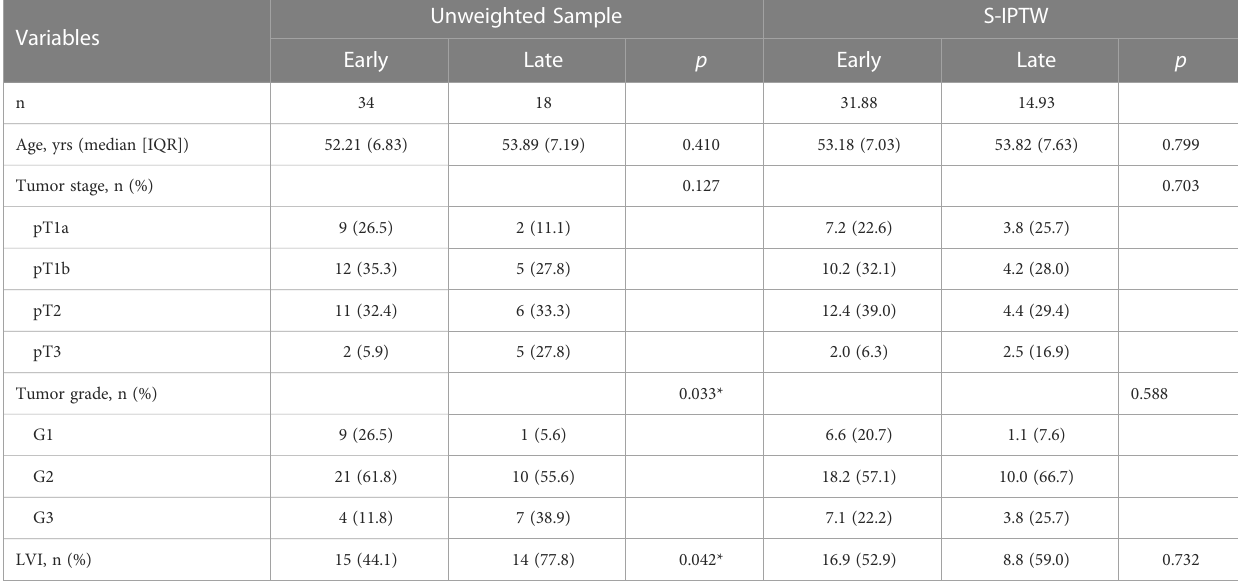
TABLE 4 Descriptive characteristics of 52 patients who underwent either early ILND or late ILND, with unweighted and S-IPTW adjustments. Unweighted Sample S-IPTW Variables Early Late p Early Late